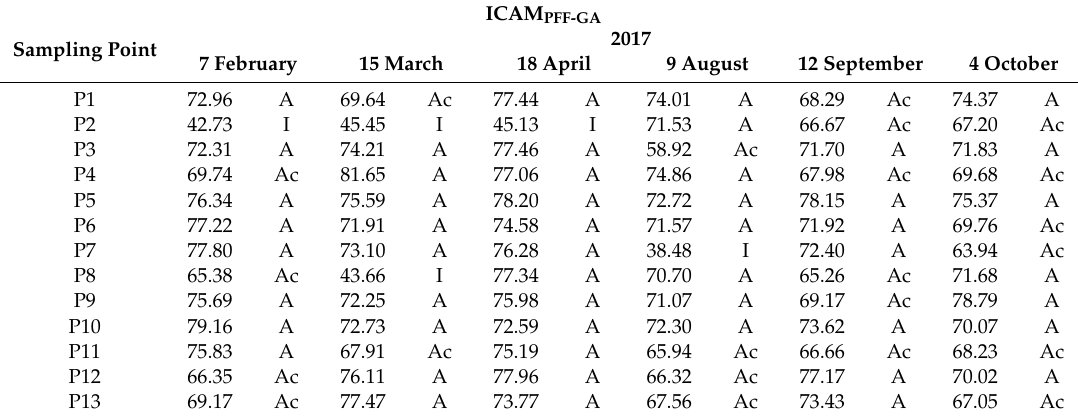
Table 6. ICAM PFF-GA results.